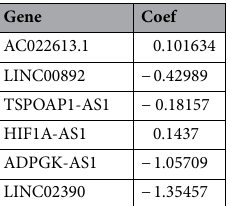
Table 2. The model information of lung adenocarcinoma.